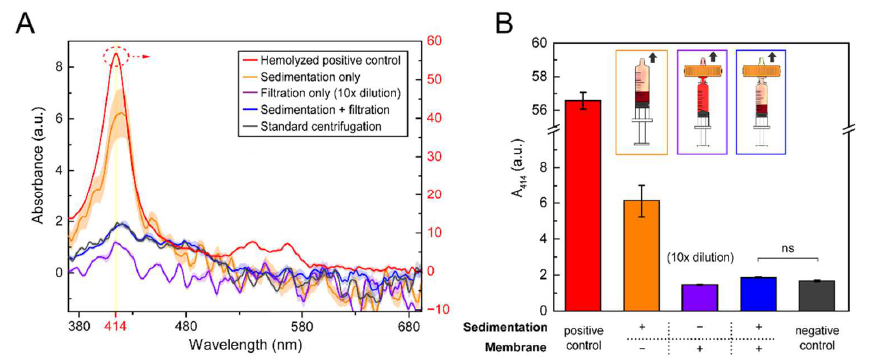
Figure 3. Plasma extraction performance under different whole blood processing methods: ( A ) The UV–Vis absorbance spectra of the extracted plasma processed by (1) artificially hemolyzing whole blood followed by centrifugation (red line; the optical density (OD) value is shown on the right Y-axis), (2) sedimentation only (orange line), (3) filtration only (with 10 × dilution; purple line), (4) sedimentation + filtration (blue line), and (5) standard centrifugation (black line). The light bandwidth represents the corresponding standard deviations ( n = 3). ( B ) The absorbance spectra at 414 nm (A 414 ) of the five whole blood processing methods. The inset shows the operation schematics of the sedimentation-only, filtration-only, and sedimentation + filtration